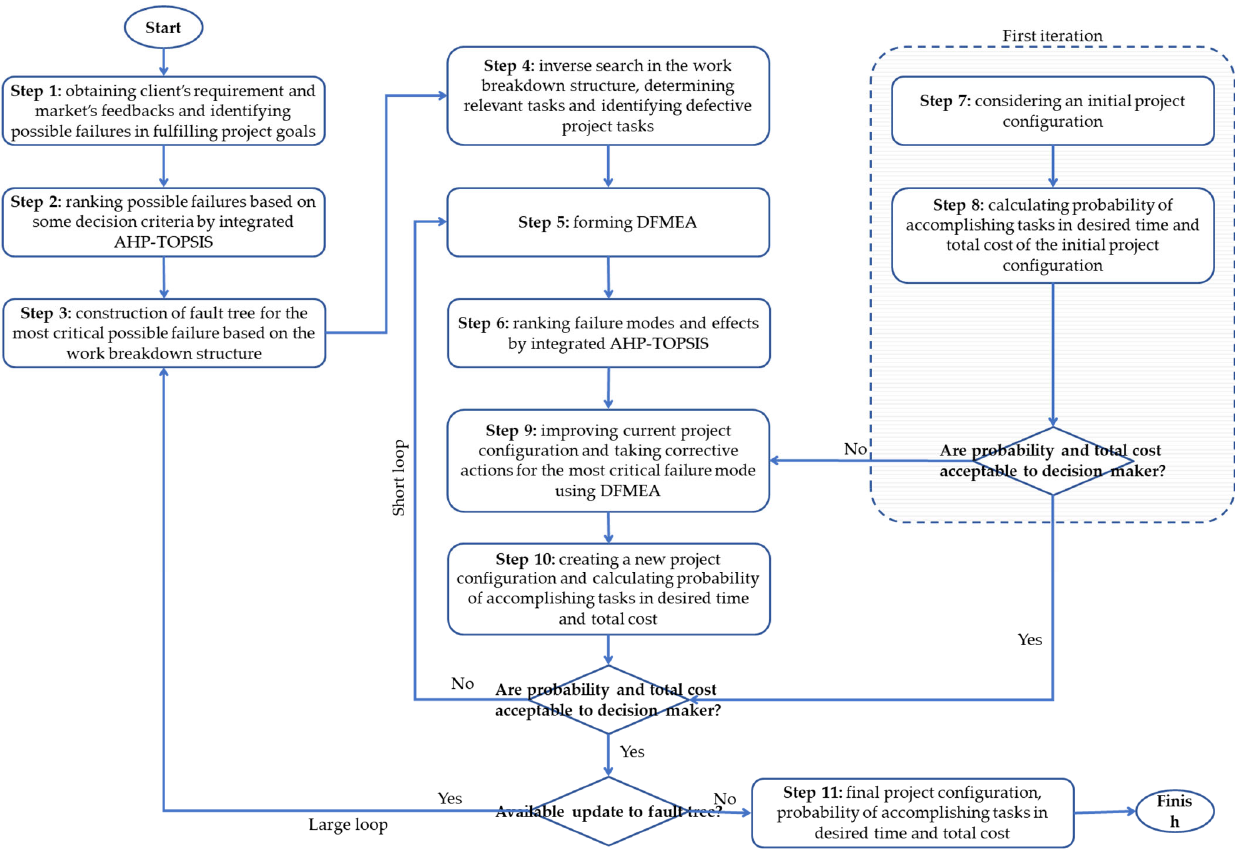
Figure 1. The entire methodology of the study.